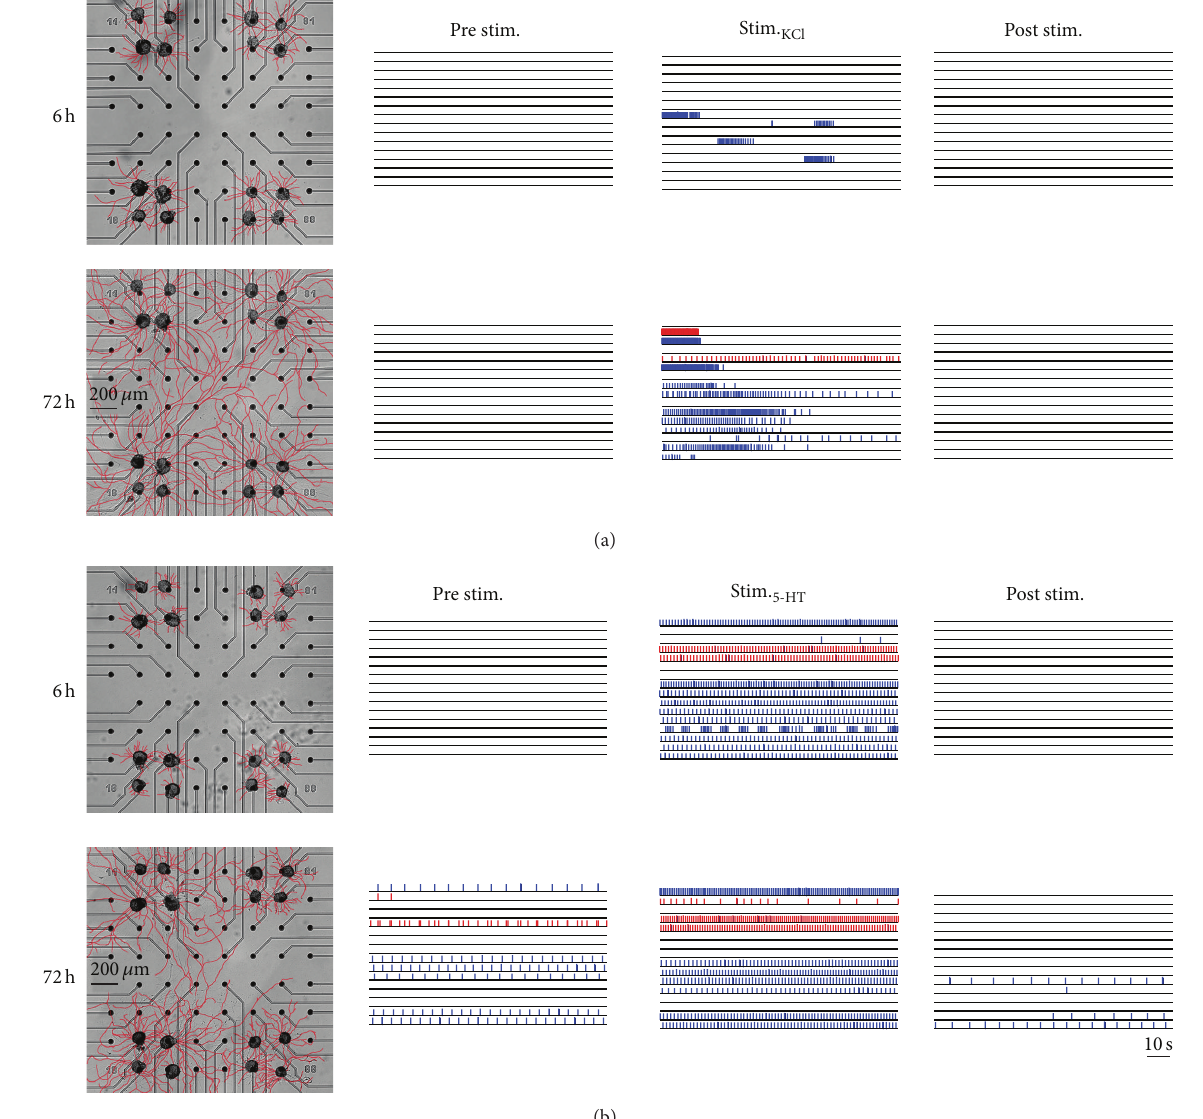
Figure 2: Example of Helix cultures treated with KCl (a) or 5-HT (b) applications. Each block represents a time-point of recordings (i.e., 6, 72 hours after plating). In the first column, the development of the neurite arborizations is indicated (scale bar is 200 𝜇 m). The three columns of raster plots show one minute of electrophysiological activity just before, during, and after the KCl or 5-HT treatment. Red and blue lines indicate recordings from C1 and B2 neurons, respectively. Scale bar is 10 s. Modified from